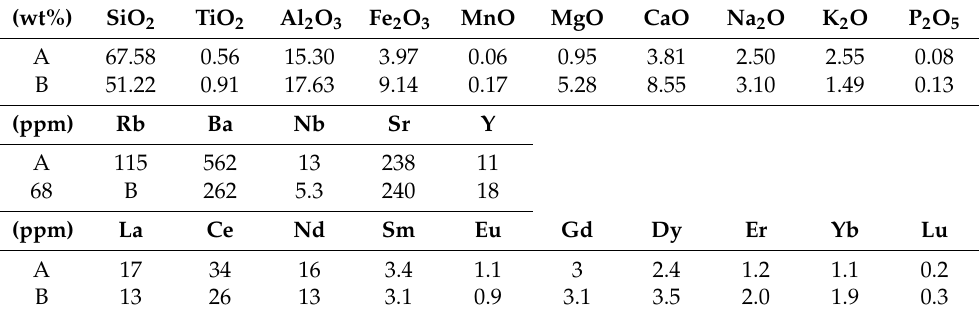
Table 3. The chemical compositions of the Ryoke plutonic rocks as source rocks of the granite magma.